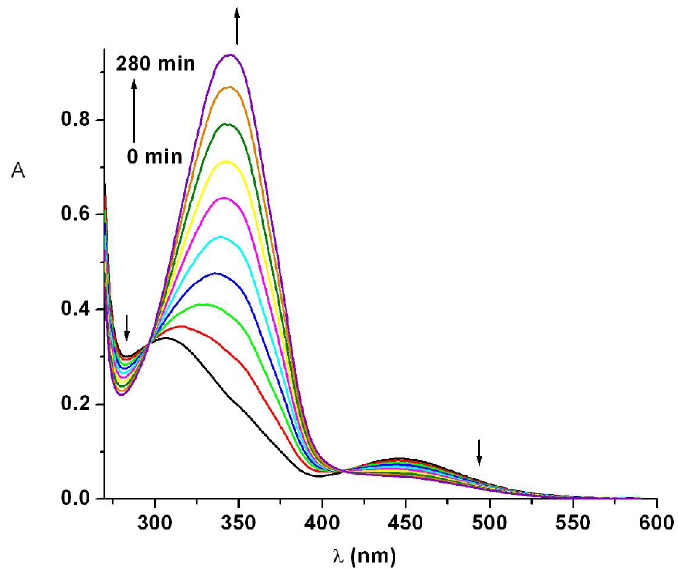
Figure 5. Absorption spectral changes of ABM 2 in DMF during thermal recovery at 60 °C.